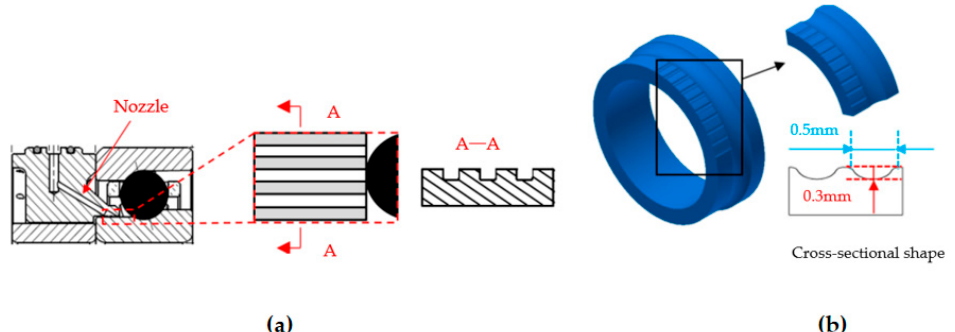
Figure 20. Axial groove structure and design position in the bearing, ( a ) Axial groove structure; ( b ) Bearing inner ring with groove structure (Adapted from [175] ).